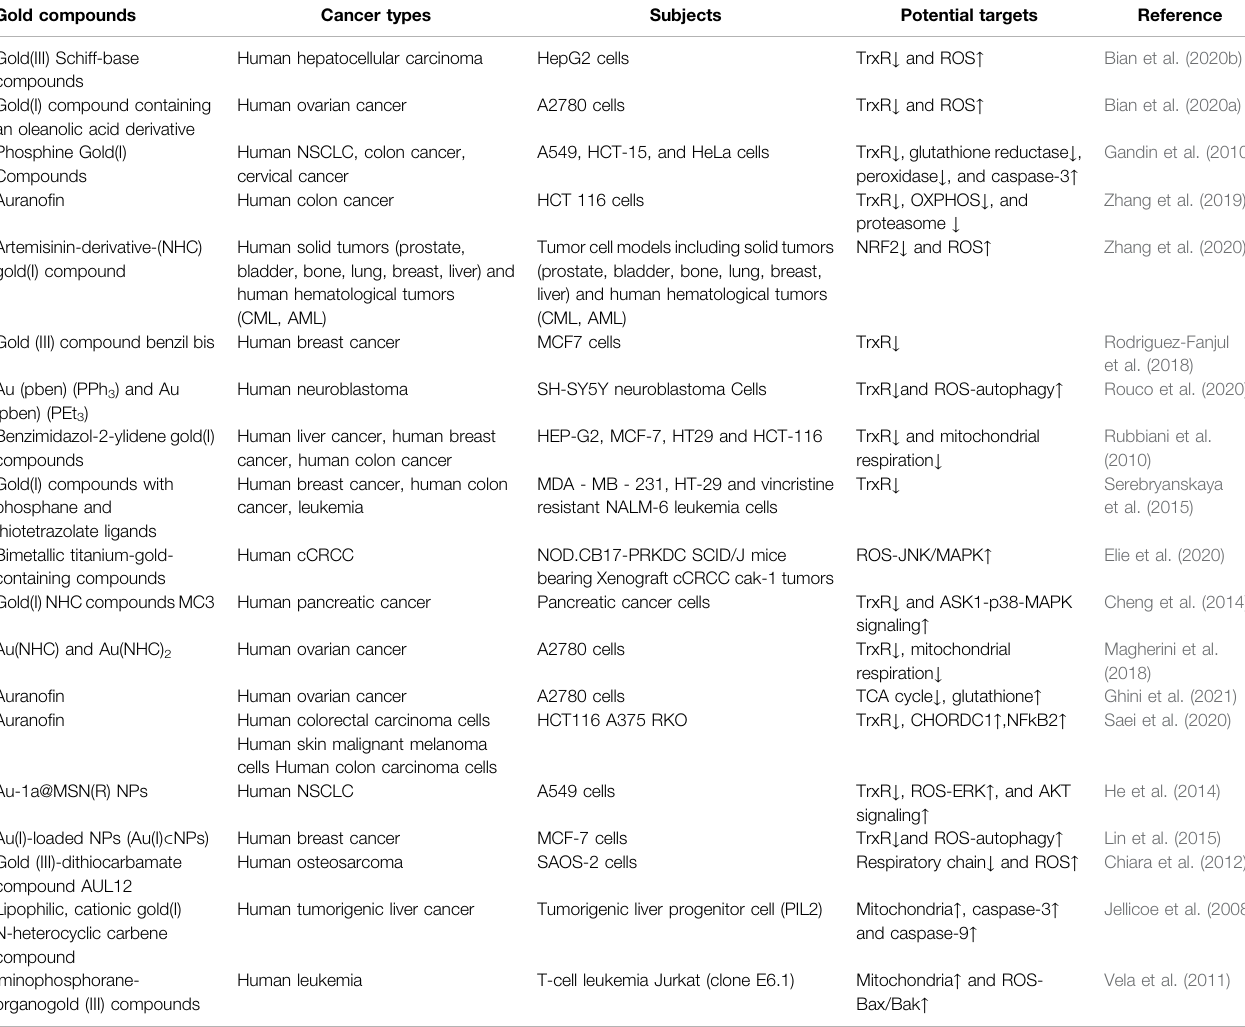
TABLE 2 | Gold compounds inhibit the growth of tumor cells by acting on ROS through various targets. Gold